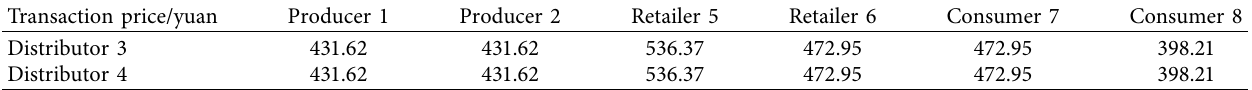
Table 2: Transaction prices of green products in the GSCDN.